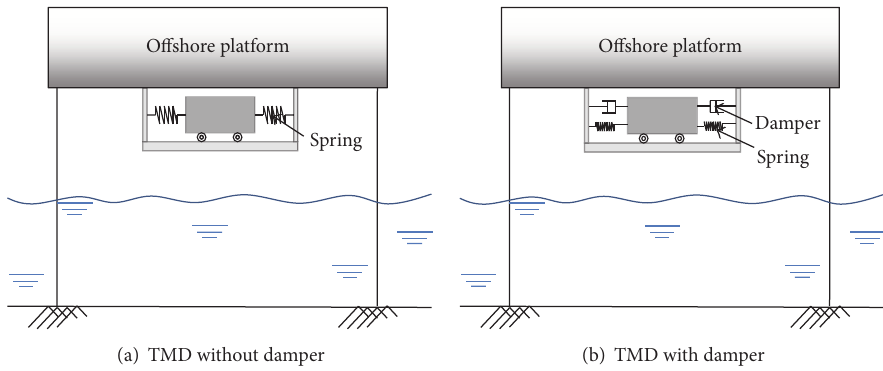
Figure 1: Schematic of a jack-up offshore platform with TMD without damper (a) and TMD with damper (b).